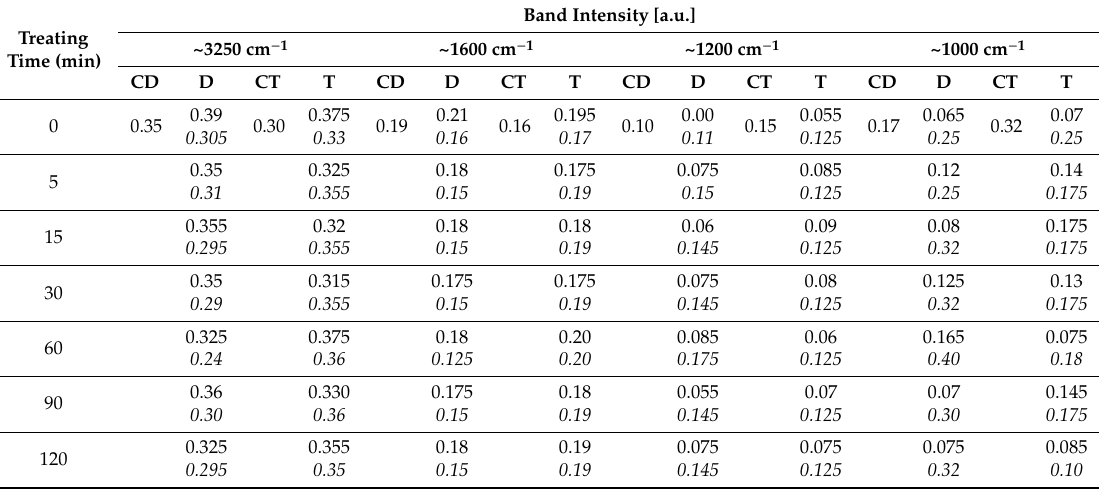
Table 6. Band intensity [a.u] in Fourier transformation infrared-attenuated total reflectance (FTIR-ATR) spectra of control (C), deionized (D) and tap (T) WST and WTS a,b . Treating Time (min)